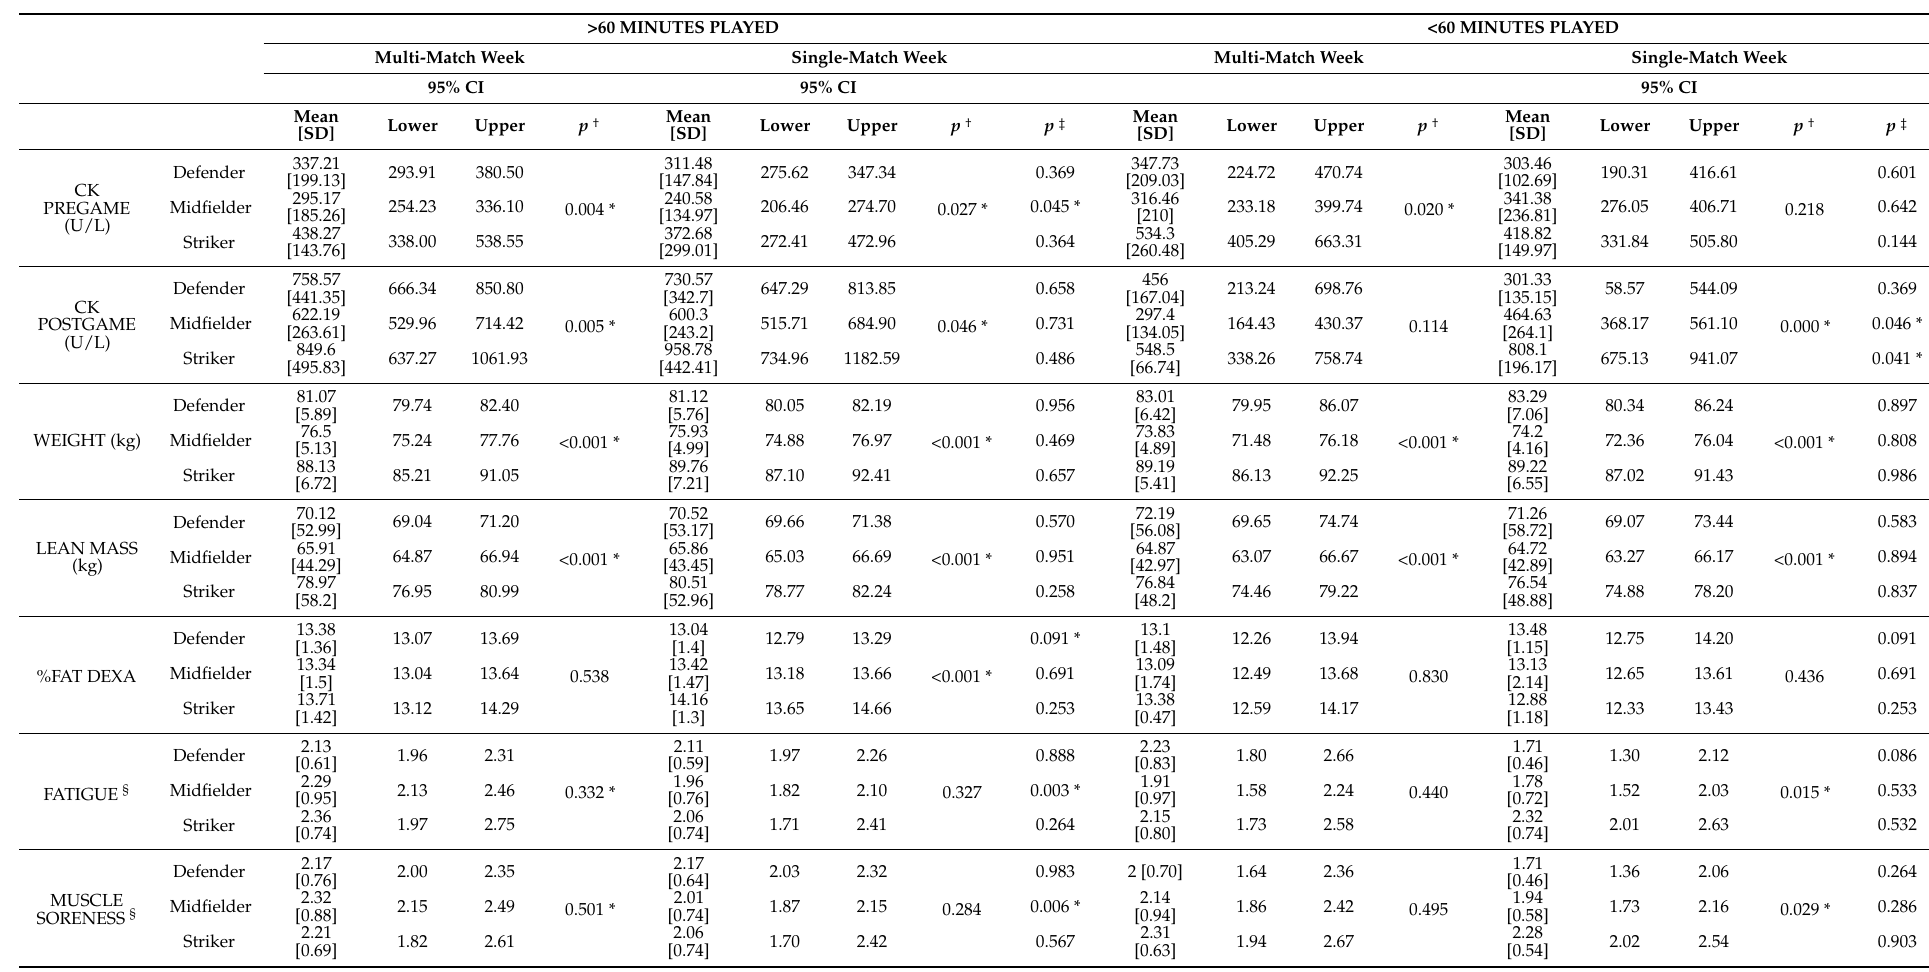
Table 3. Comparative assessment of muscle damage, wellbeing, body composition and match performance data in multi-match vs. single-match weeks according to player position. >60 MINUTES PLAYED <60 MINUTES PLAYED Multi-Match Week Single-Match Week Multi-Match